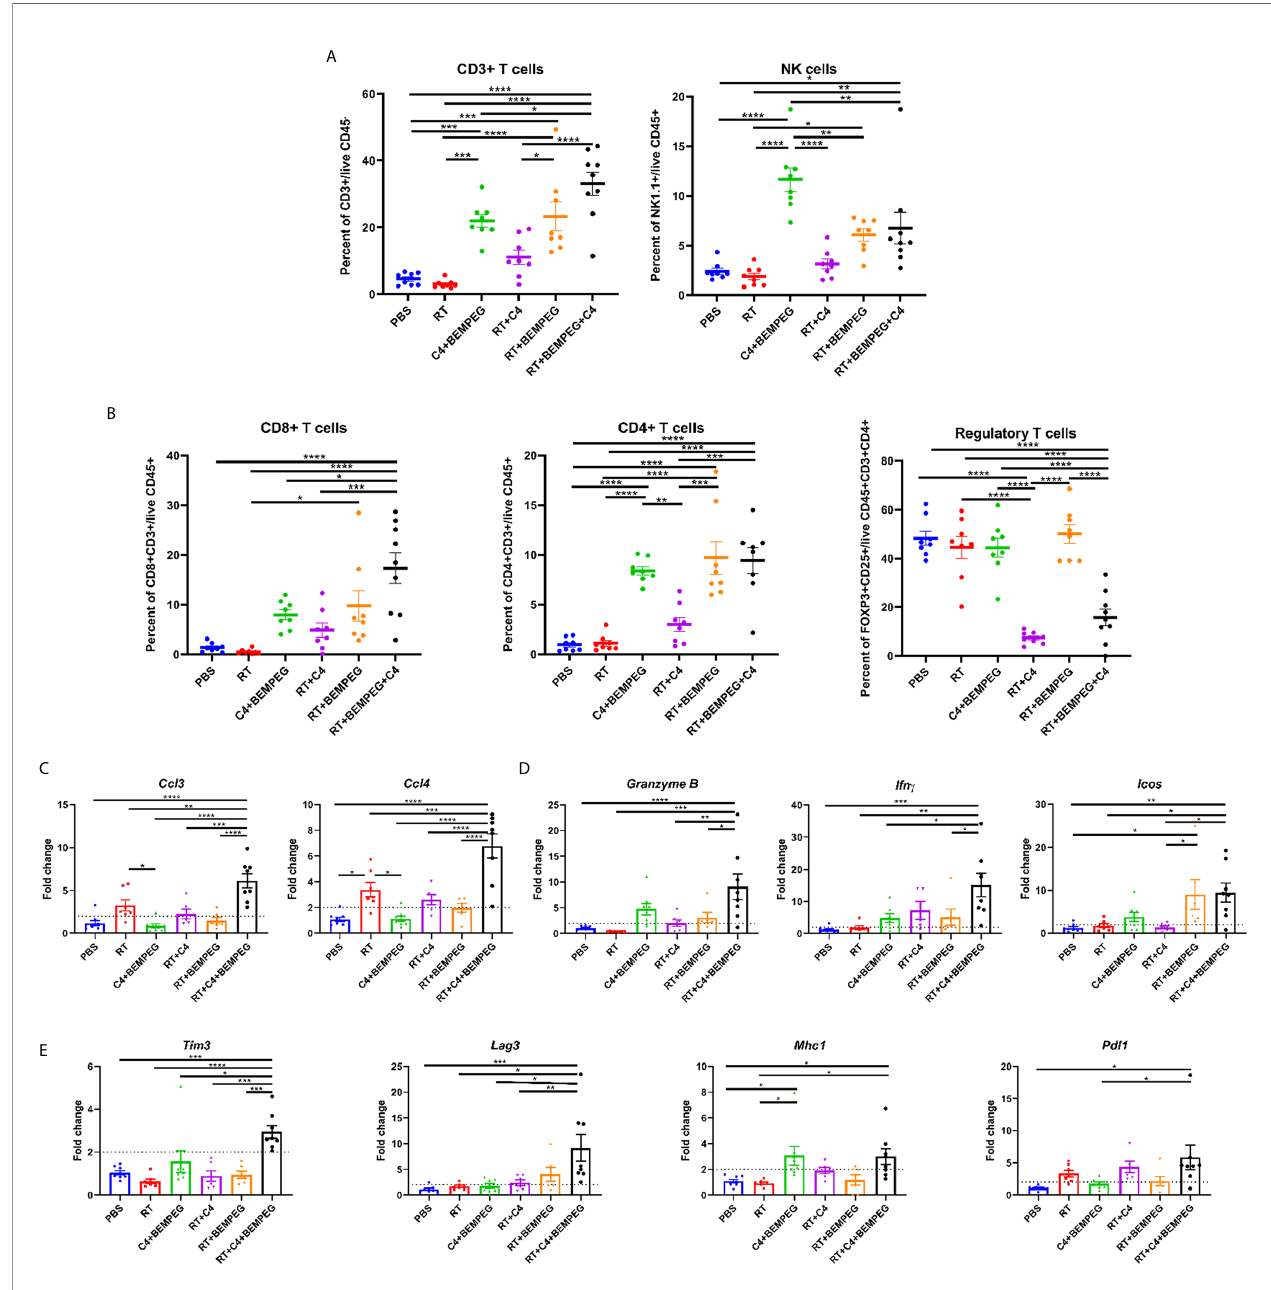
FIGURE 3 | BEMPEG and anti-CTLA-4 combined with local radiation creates a favorable adaptive immune microenvironment. Mice bearing a fl ank LLC tumor (~80mm 3 ) were given 8 Gy x 3 locally combined with BEMPEG and anti-CTLA-4 (C4) treatments. At day 20 tumors were harvested and processed for qRT-PCR and fl ow cytometric analyses. (A, B) Flow cytometry tumor in fi ltrates are shown as a percent of parent or grandparent gate. (C) Expression of genes associated with immune cell recruitment, (D) cytotoxic T lymphocyte activation, and (E) immune susceptibility are displayed as fold change in expression relative to the PBS control (mean ± SEM, n ≥ 8). A one-way ANOVA followed by a post hoc multiple comparisons test with Tukey adjustments for p-values was used to determine statistical differences among cell populations and gene expression (mean ± SEM, n ≥ 8, **** = P <0.0001; ***=P<0.001; **=P<0.01;